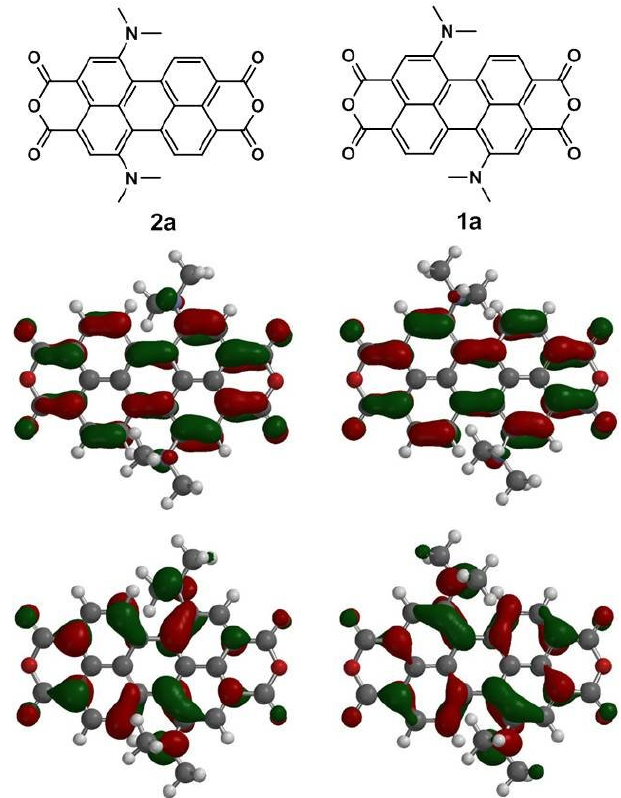
Figure 7. Calculated frontier orbitals for 1a and 2a . The upper structures show the LUMOs and the lower ones show the HOMOs. Methyl groups replace the hexyl groups for clarity.